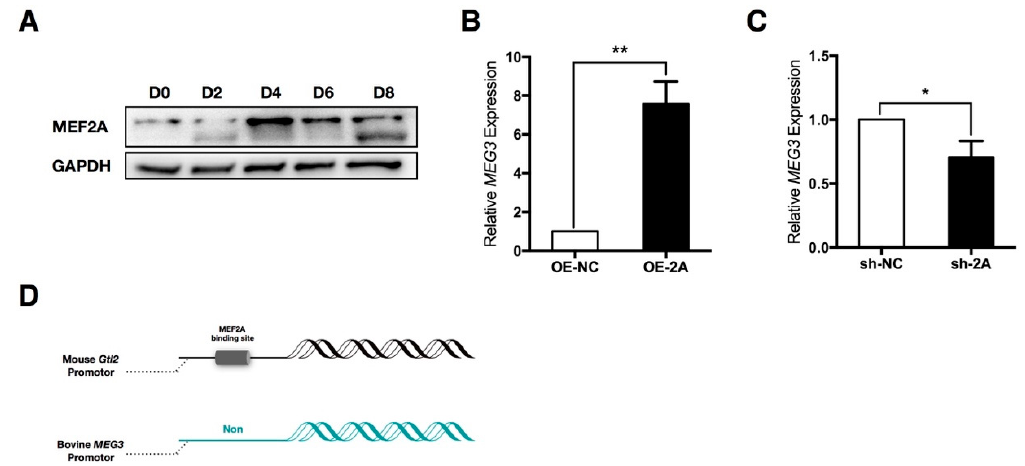
Figure 1. Myocyte enhancer factor 2A (MEF2A) is sufficient to induce maternally expressed 3 ( MEG3 ) expression. ( A ) Time course of MEF2A protein expression from differentiation day 0 (D0) to differentiation day 0 (D8) of myoblasts; ( B ) Overexpression of MEF2A obviously induced MEG3 expression in differentiated myocytes; ( C ) Inhibition of MEF2A repressed MEG3 expression in differentiated myocytes; ( D ) Transcription factor binding motif prediction of the mouse Gtl2 promotor and bovine MEG3 promotor. Error bars represent standard error of the mean (SEM). “*” represents p < 0.05. “**” represents p < 0.01.